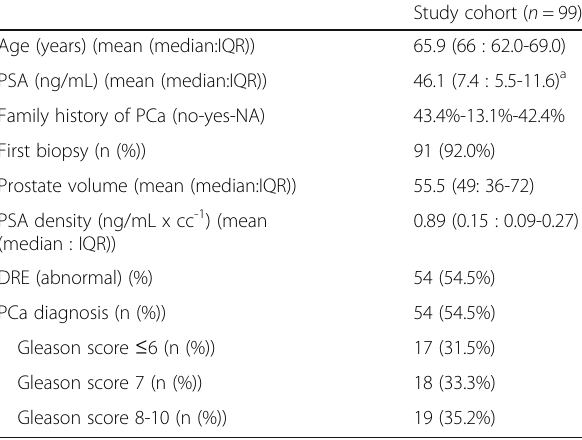
Table 1 Characteristics of the study population